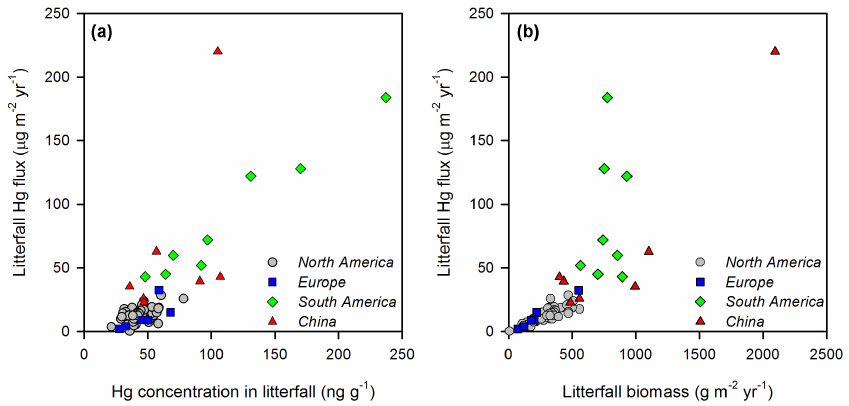
Figure 7. Scatterplot of (a) Hg concentrations in litterfall and litterfall fluxes of Hg, and (b) litterfall biomasses and litterfall fluxes of Hg for the global observations. Data are from this study and the literature (Iverfeldt, 1991; Rea et al., 1996; Roulet et al., 1998; Fostier et al., 2000; Grigal et al., 2000; Schwesig and Matzner, 2000; St. Louis et al., 2001; Mélières et al., 2003; Magarelli and Fostier, 2005; Sheehan et